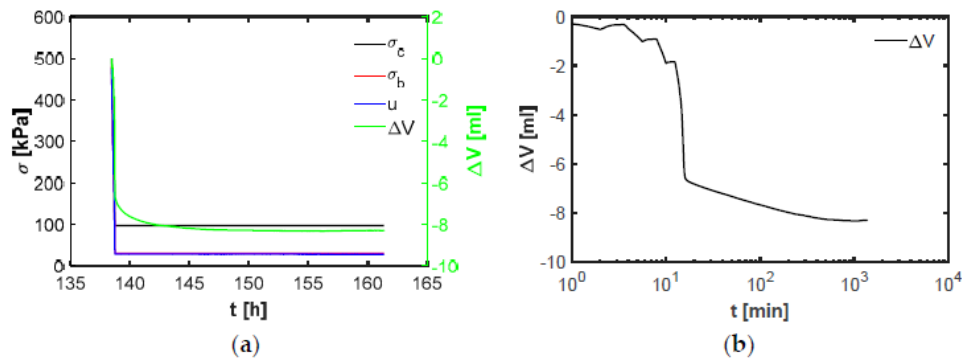
Figure 9. Consolidation phase time plots for soil mM: ( a ) pressures and volume change vs. time; ( b ) volume change vs. time.